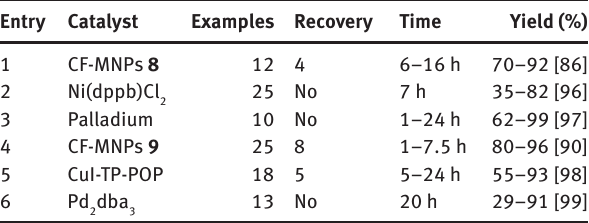
Table 6: Comparison of the activity of CF-MNPs catalysts with other reported catalysts in C-C (entries 1–3) and C-O (entries 4–6) coupling reactions.